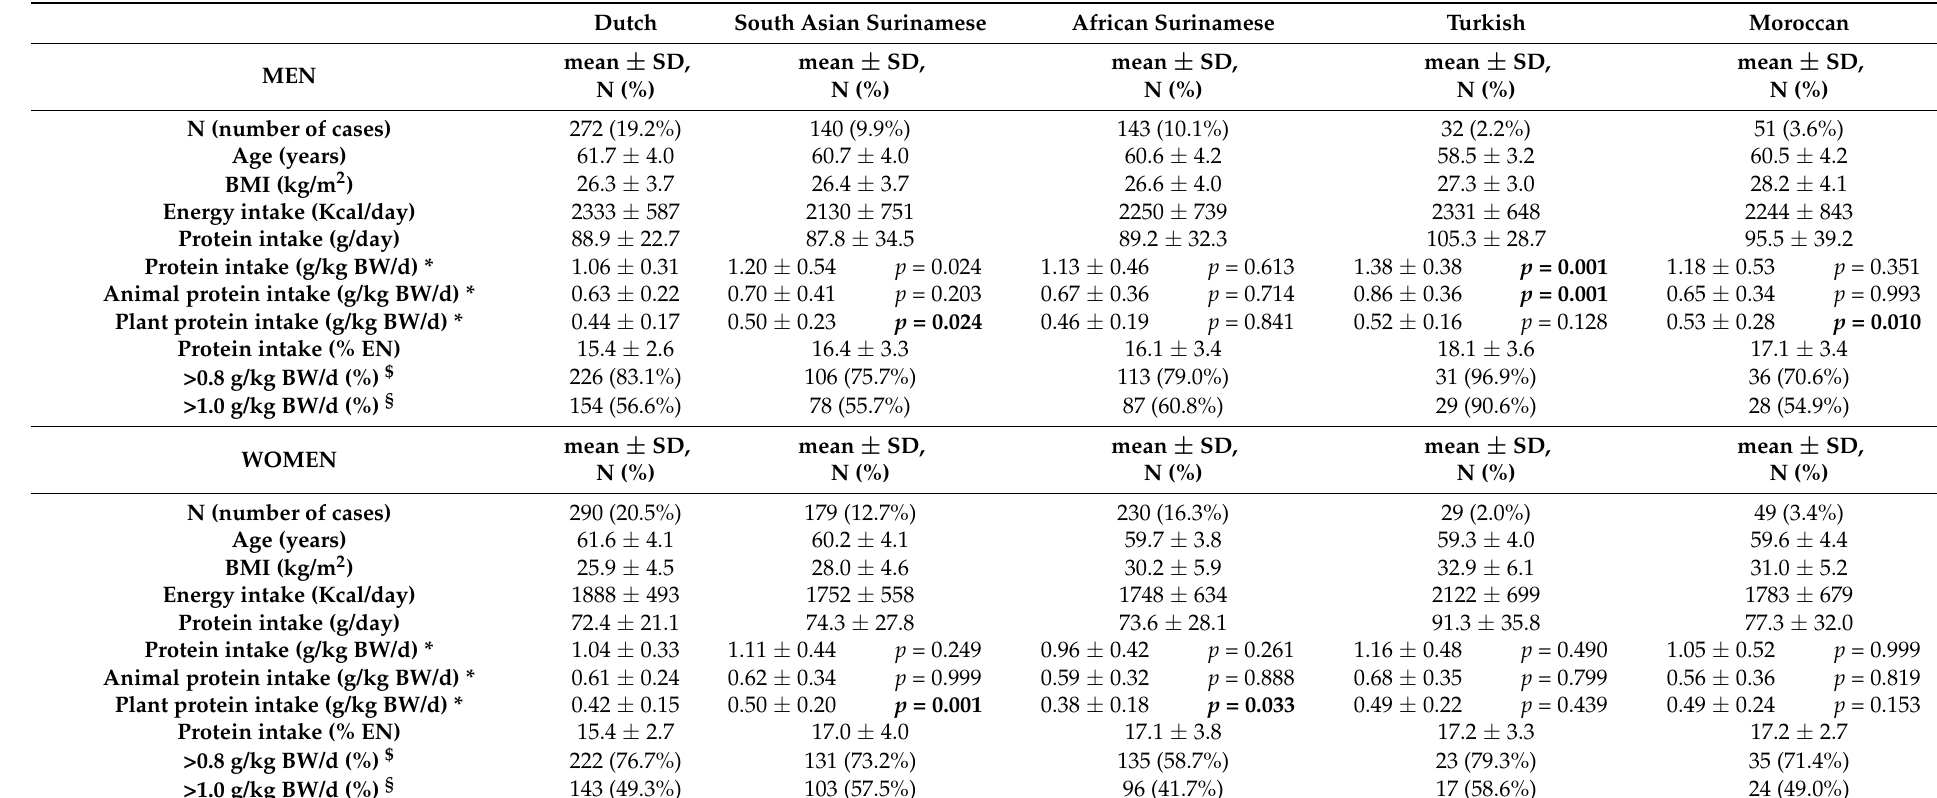
Table 1. Characteristics of the subsample from participants of Healthy Life in an Urban Setting (HELIUS) (N = 1415). Dutch South Asian Surinamese African Surinamese